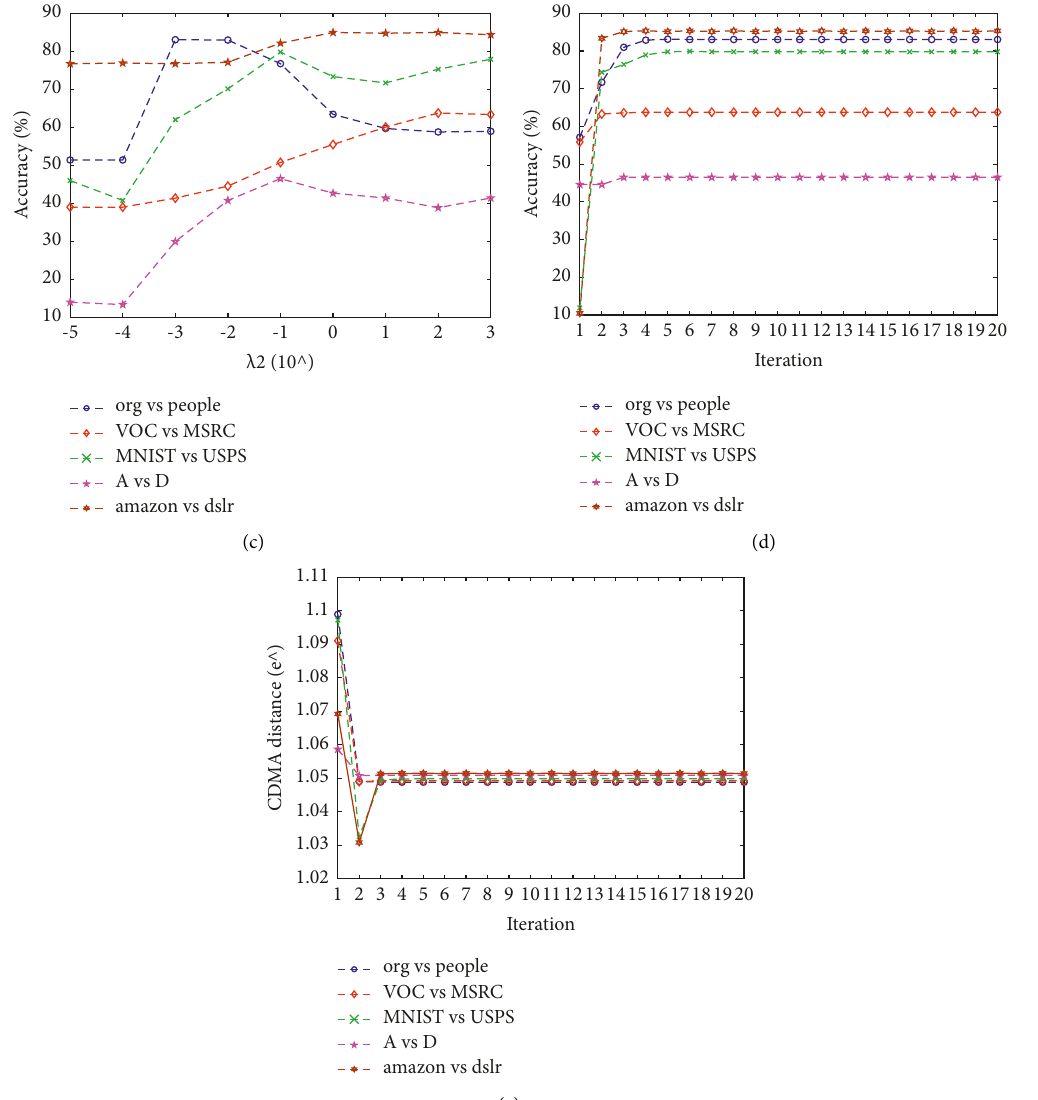
Figure 12: CDMA distance and Effect of iteration and parameter α